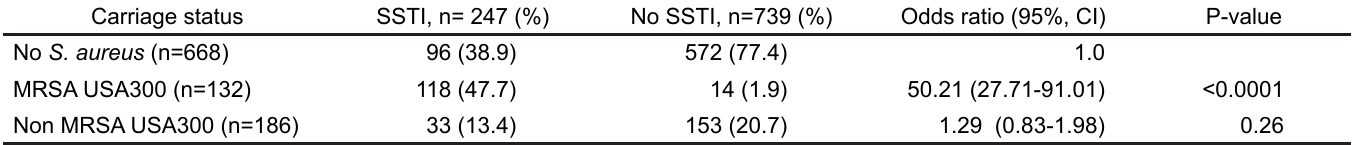
Table 3. Relationship of S. aureus carriage and presence of skin and soft tissue